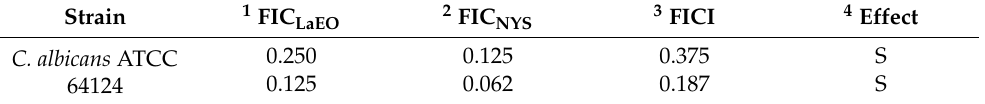
Table 6. Modulatory effect of LaEO on the antifungal activity of nystatin (NYS) on Candida strains. Strain